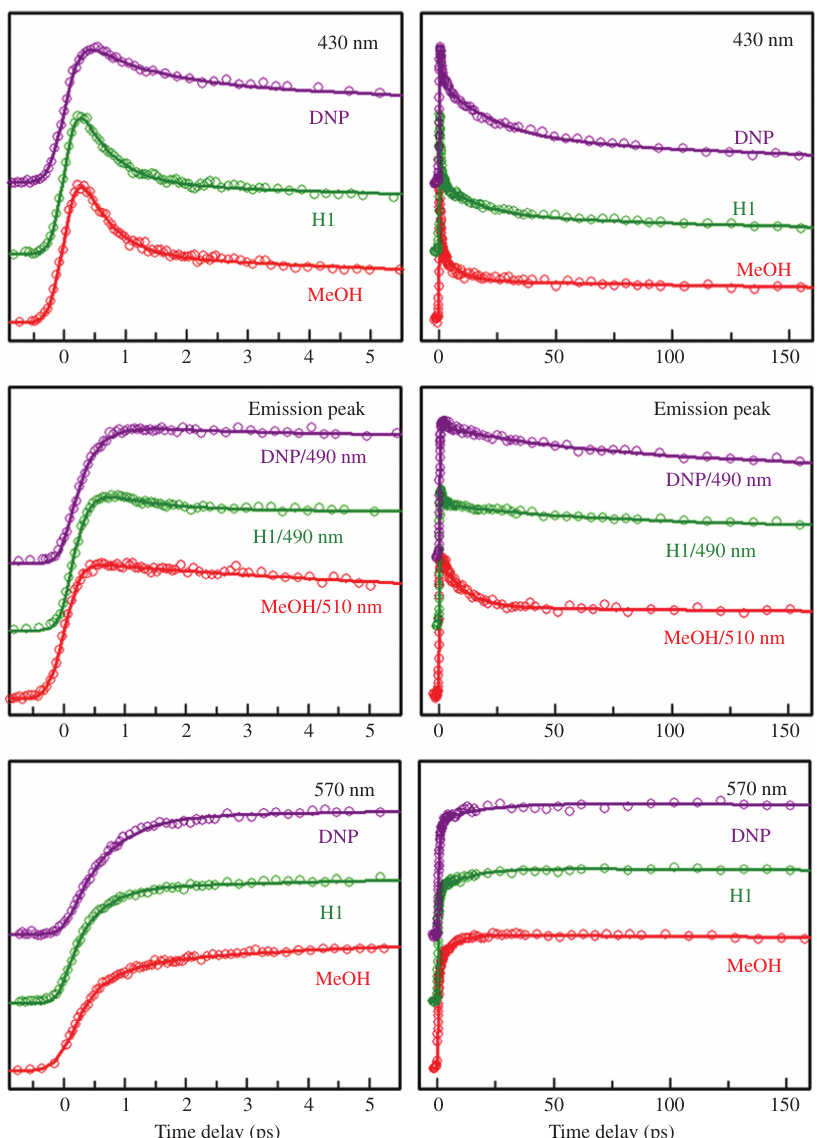
Figure 8 The observed transients of DC in MeOH and the different biological environments studied. Two time scales are shown, short (left) and long (right), for three typical fluorescent wavelengths: the blue side, emission peak, and the red side. Note the difference of transients for H1 and DNP, even though both have the same fluorescence emission (Figure 2B). All transients are normalized for comparison. [Reprinted with permission from ref. (17) Copyright 2001, Wiley-VCH-Verlag GmbH.] recognition of protein/DNA relative to that of